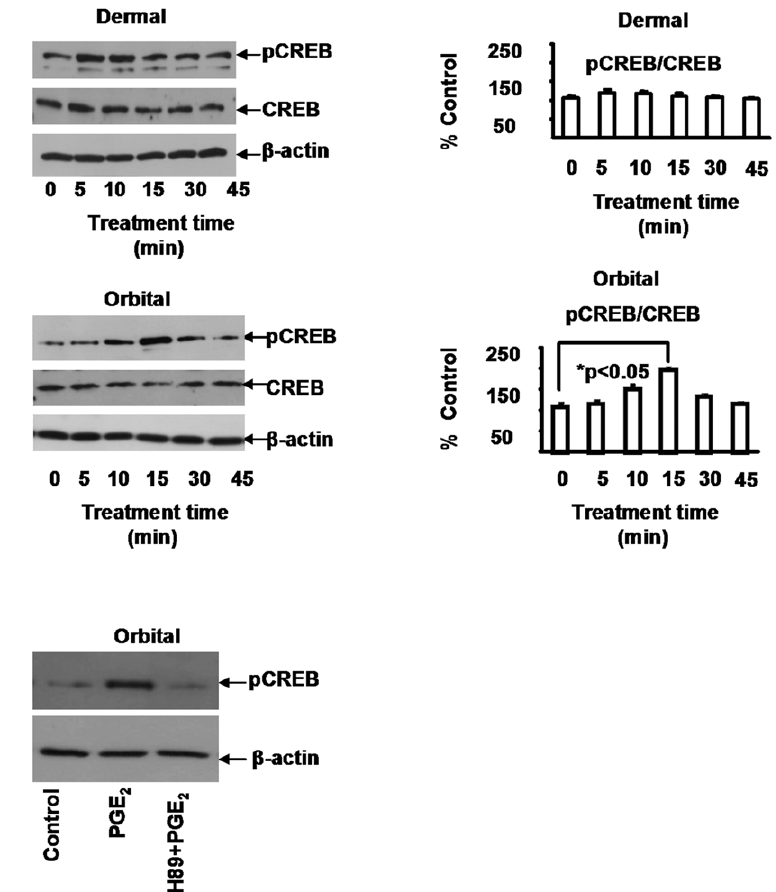
Figure 4. PGE 2 provokes the phosphorylation of CREB in orbital fibroblasts, an effect blocked with H89. A : Confluent cultures were treated with PGE 2 (1 m M) for different intervals. Cellular proteins were subjected to Western blot analysis of CREB and pCREB. Densitometric analysis of pCREB protein concentrations are expressed as the ratio to total CREB protein as a percent of the value at ‘‘0’’ min. Data are expressed as the mean 6 SD of triplicate independent determinations. (* denotes statistical significance between treatment groups). B : H89 (10 m M) inhibits PGE 2 -provoked CREB phosphorylation in orbital fibroblasts. The inhibitor was added for 6 hrs, followed by addition of PGE 2 (1 m M) for 15 min. Cellular proteins were subjected to Western blot analysis of pCREB protein using b -actin as a loading control.